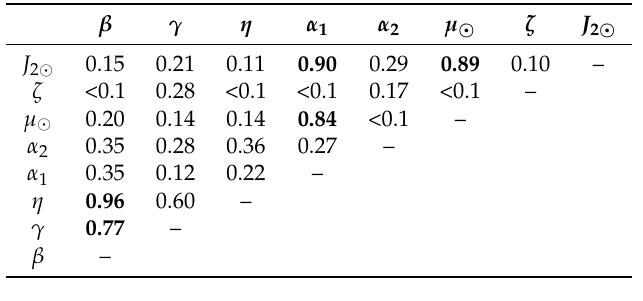
Table 2. Correlations between PN and related parameters (values higher than 0.7 are highlighted in bold). β